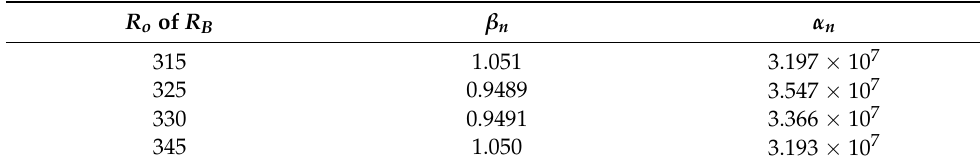
Table 2. β n and α n for the four bolometers shown in Figure 7.